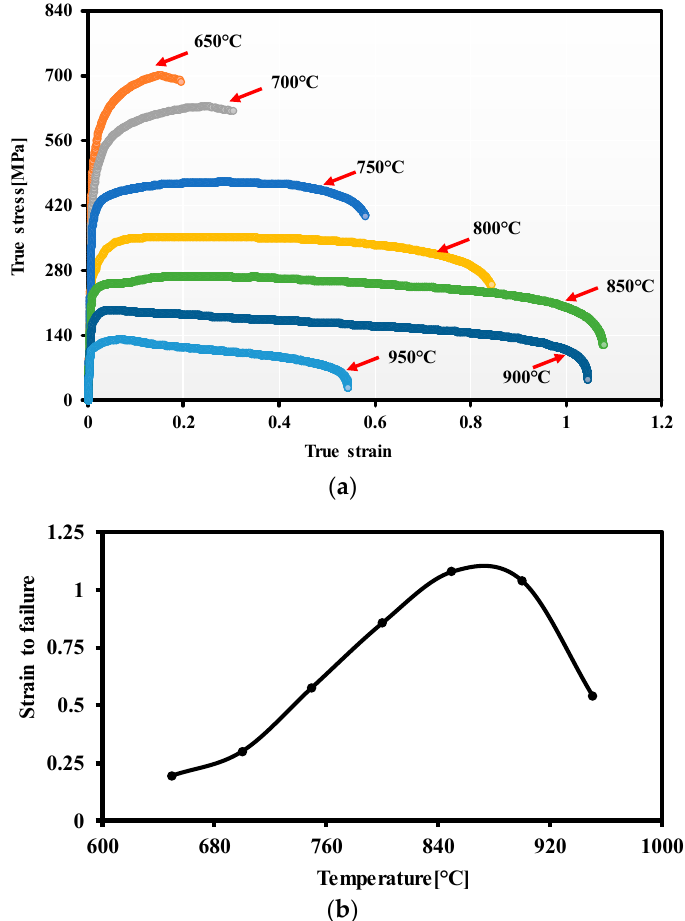
Figure 5. Hot tensile test results: ( a ) Stress-strain relationships and ( b ) variations of alloy ductility with temperature.